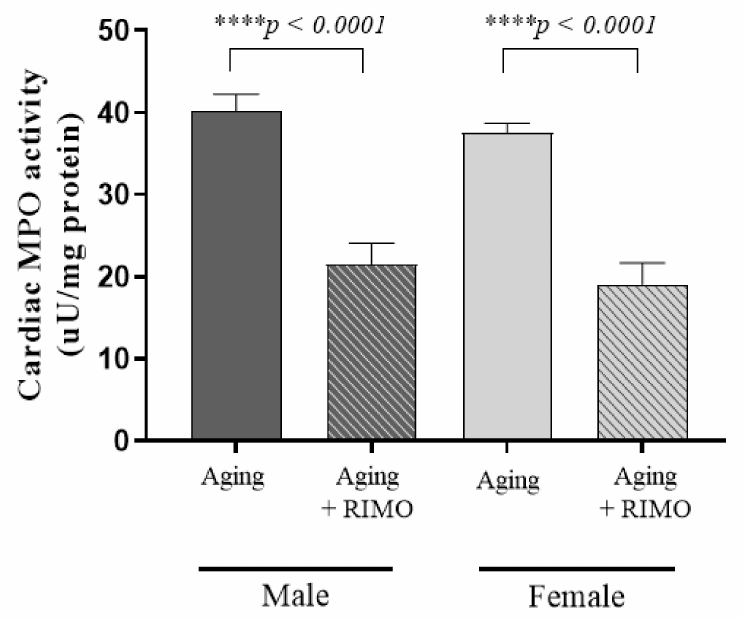
Figure 6. The effects of rimonabant treatment on cardiac MPO activity in aged animals. (MPO; ex- pressed as µ unit/mg protein). Results are shown as means ± S.E.M. n = 6–9. **** p < 0.0001: Statistical significance between rimonabant-treated and untreated, sex-matched aging rats. RIMO = rimonabant, MPO = myeloperoxidase